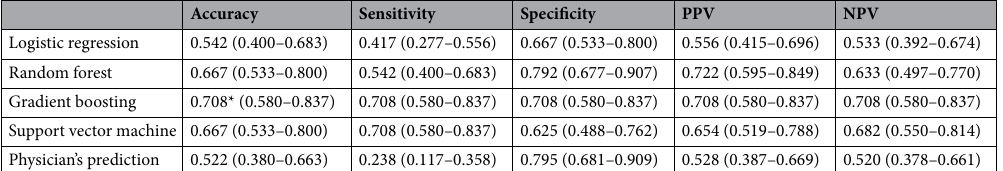
Table 3. Performance metrics of machine learning models and physician’s prediction. PPV positive predictive value, NPV negative prediction value. * p < 0.05 compared with logistic regression or physician’s prediction. The values were presented as mean (95% confidence